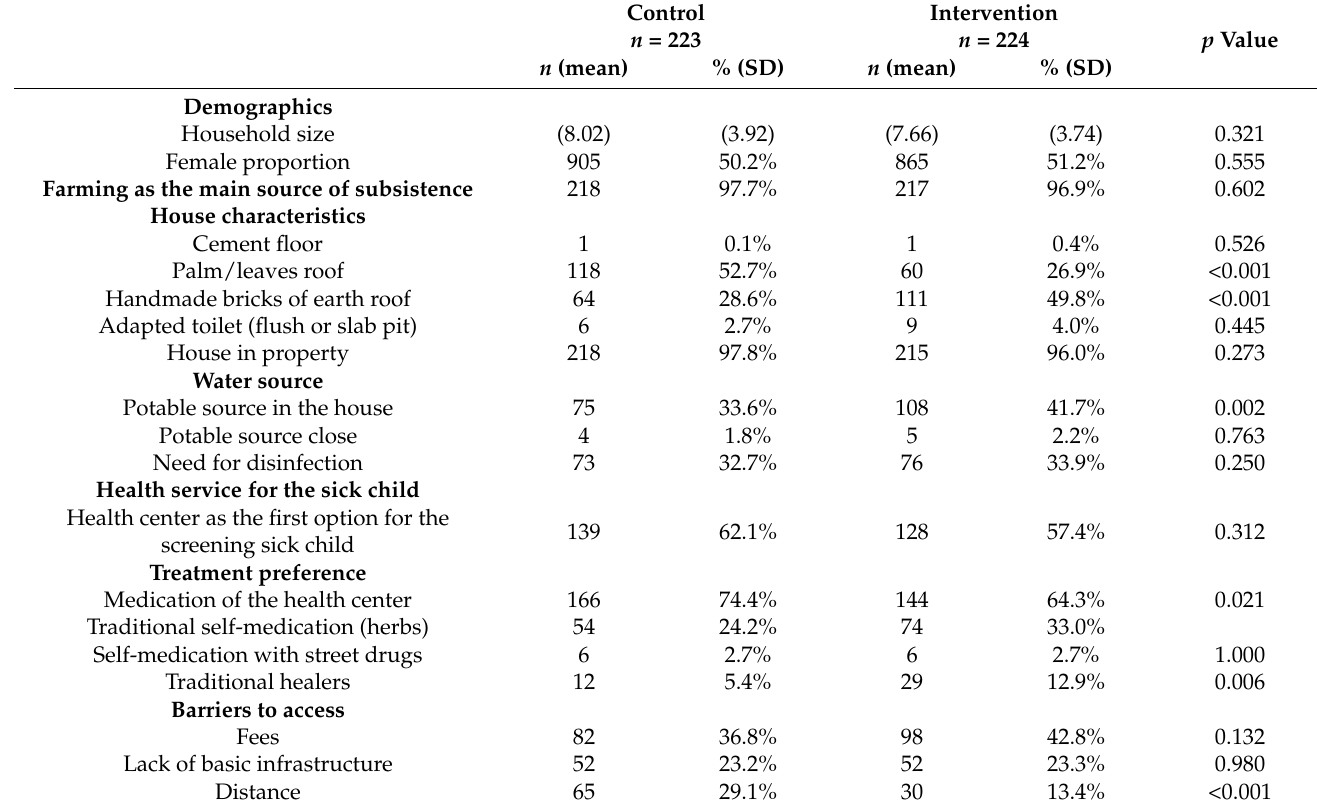
Table 1. Household sociodemographic characteristics compared between the control and intervention